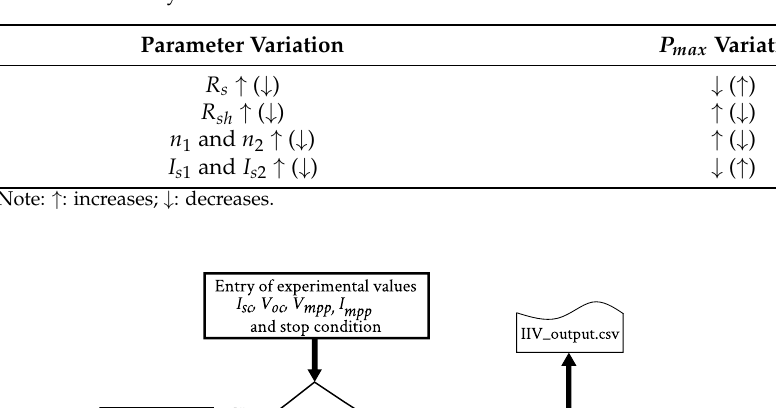
Table 1. Summary of the behavior of I-V curve.